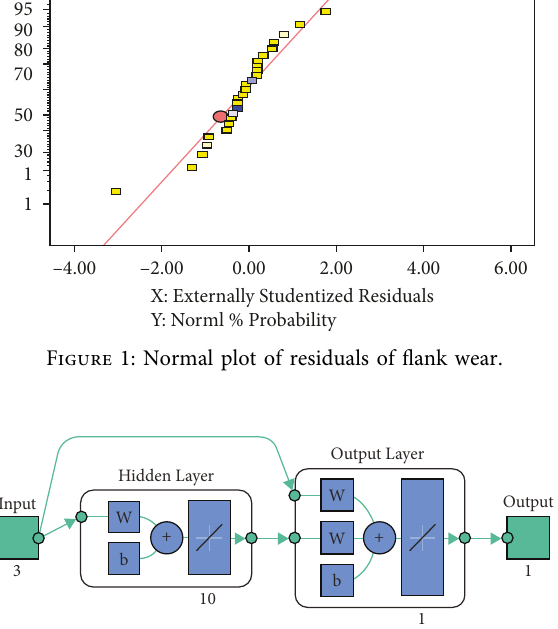
Figure 2: Two layered cascade forward back propagation network.